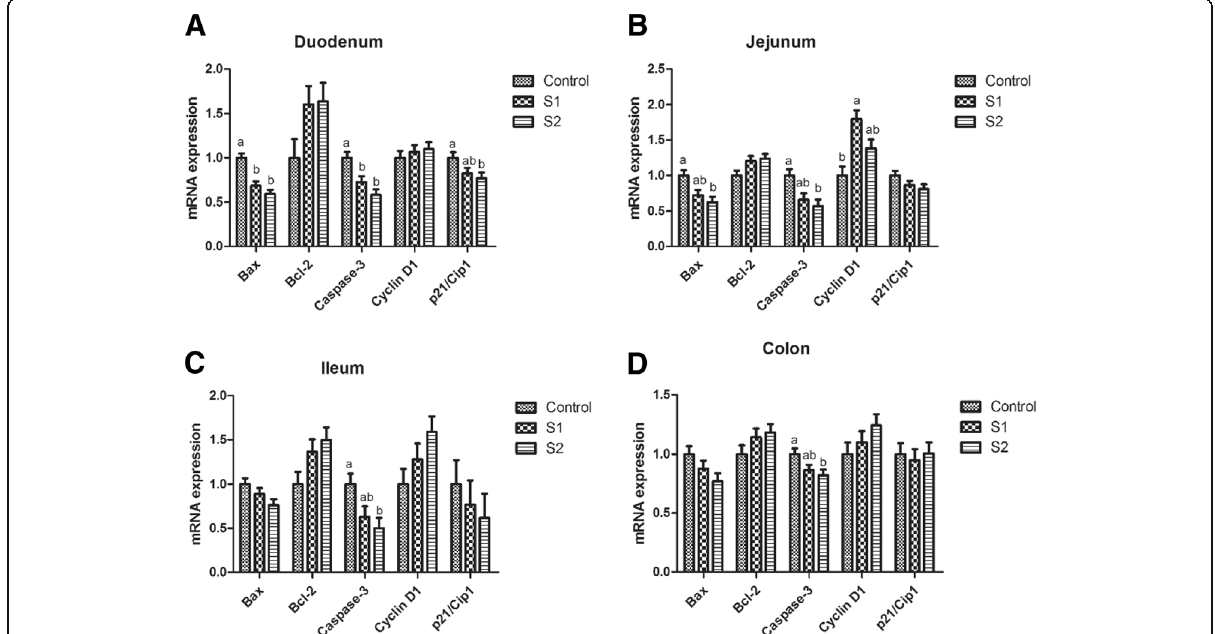
Fig. 2 Effect of gastric infusion of SCFA on the relative mRNA expressions of cell apoptosis and cycle-related genes in duodenum, jejunum, ileum, and colon of weaned piglets. S1, pigs treated with SCFA (acetic, propionic, and butyric acids; 20.04, 7.71, and 4.89 mM respectively); S2, pigs treated with SCFA (acetic, propionic, and butyric acids; 40.08, 15.41, and 9.78 mM respectively). a, b, means without a common superscript differ ( P < 0.05)